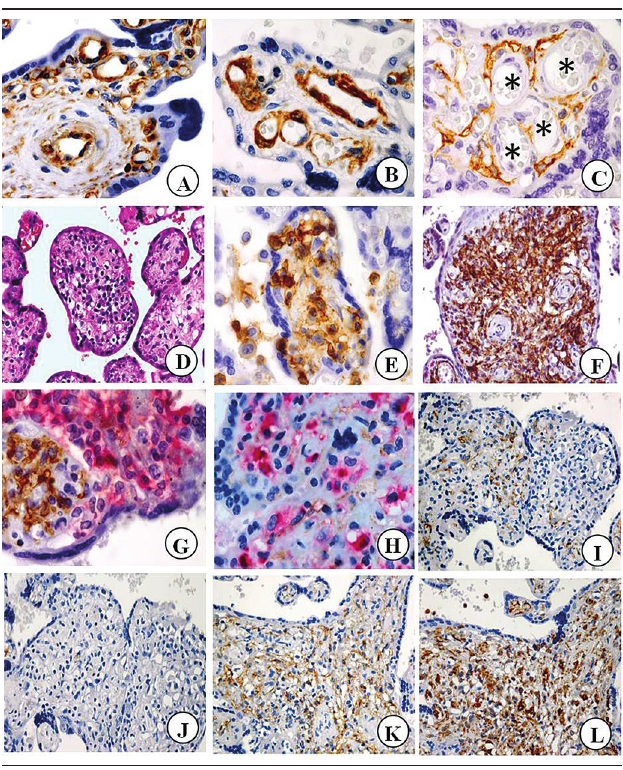
FigurE − Immunohistochemical findings in normal and inflamed villi Images A to C – normal villi of control placentas: immunostaining of vimentin (A), alpha- SMA (B) and D2-40 (C) in villous tissue sections. Note vimentin expression in vascular walls and extravascular stromal cells; alpha-SMA expression in vascular walls; D2-40+ cells delineating a lymphatic-like conductive network around fetal blood vessels (*) (original magnification 1000×). Images D to L – inflamed villi of placentas with chronic villitis. D: immune cells within villous stroma (HE staining, original magnification 400×); E: CD3+ T lymphocytes within villous stroma (original magnification 1000×); F: D2-40+ cells form a dense cellular network (original magnification 400×); G and H: double-labeling immunohistochemical staining using D2-40 (brown), CD45 (red in G) and CD68 (red in H) antibodies: co-expressions of D2-40/CD45 and D2-40/CD68 are not observed (original magnification 1000×); I and J: serial sections stained with D2-40 (I) and alpha-SMA (J): D2-40+ stromal cells are seen in (I) whereas alpha-SMA+ cells are absent in (J) (original magnification 400×); K and L: serial sections stained with D2-40 (K) and vimentin (L): D2-40 and vimentin staining similar amounts of stromal